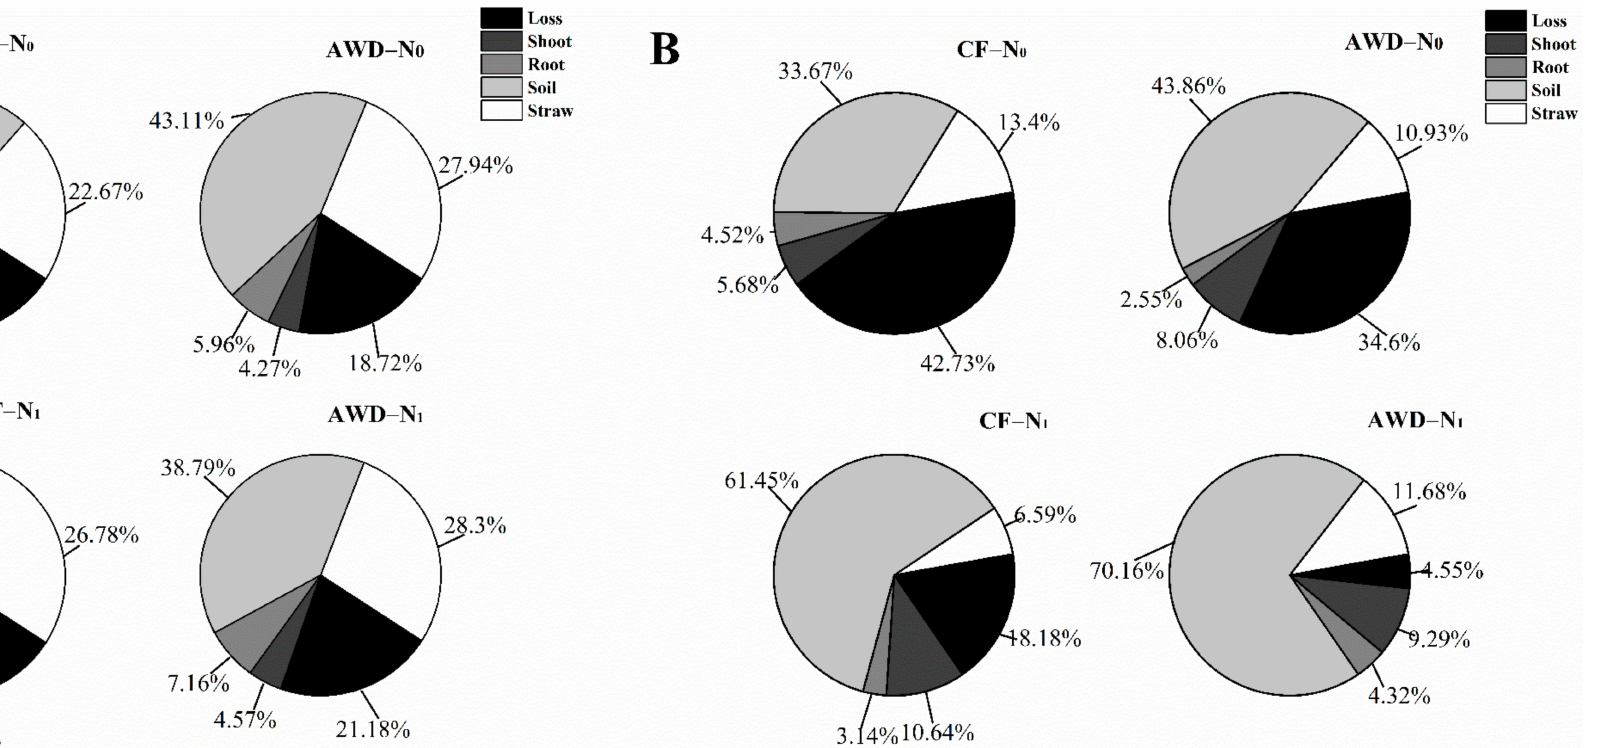
Figure 2. Distribution of straw-N at PI ( A ) and MS ( B ) in the soil–plant